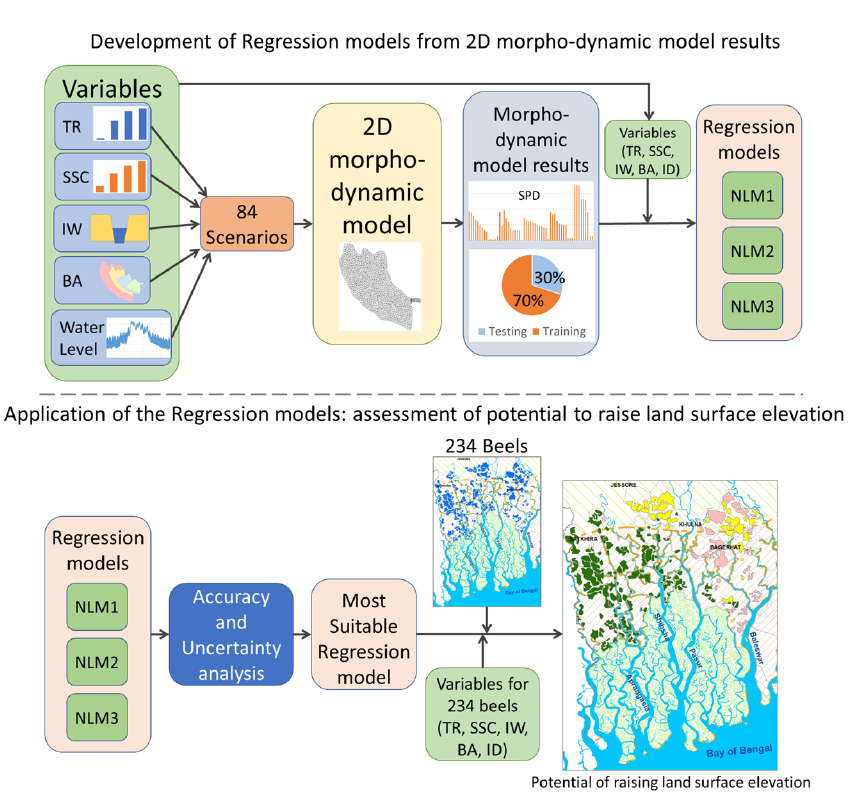
Figure 2. General approach used to establish the regression models for sediment deposition from physical control parameters and their subsequent application to estimate potential of raising land surface elevation throughout the southwestern Bangladesh